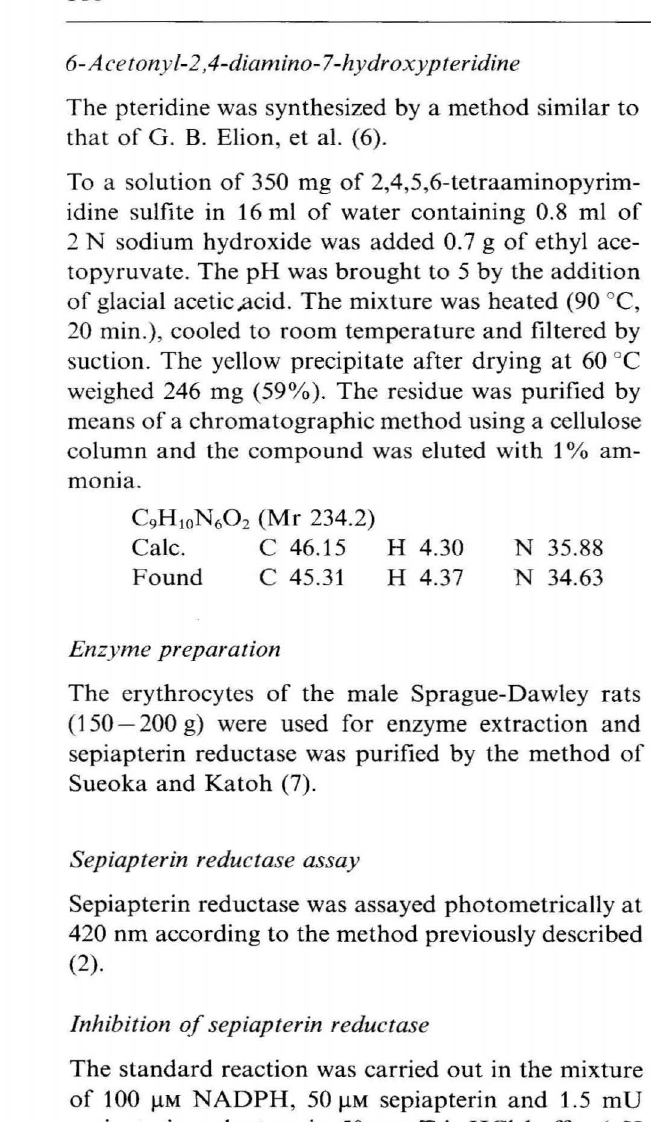
Table 1. The inhibition of sepiapterin reductase by 6-acetonyl isoxanthopterin, 6-acetonyl-2,4-diamino-7-hydroxypteridine,